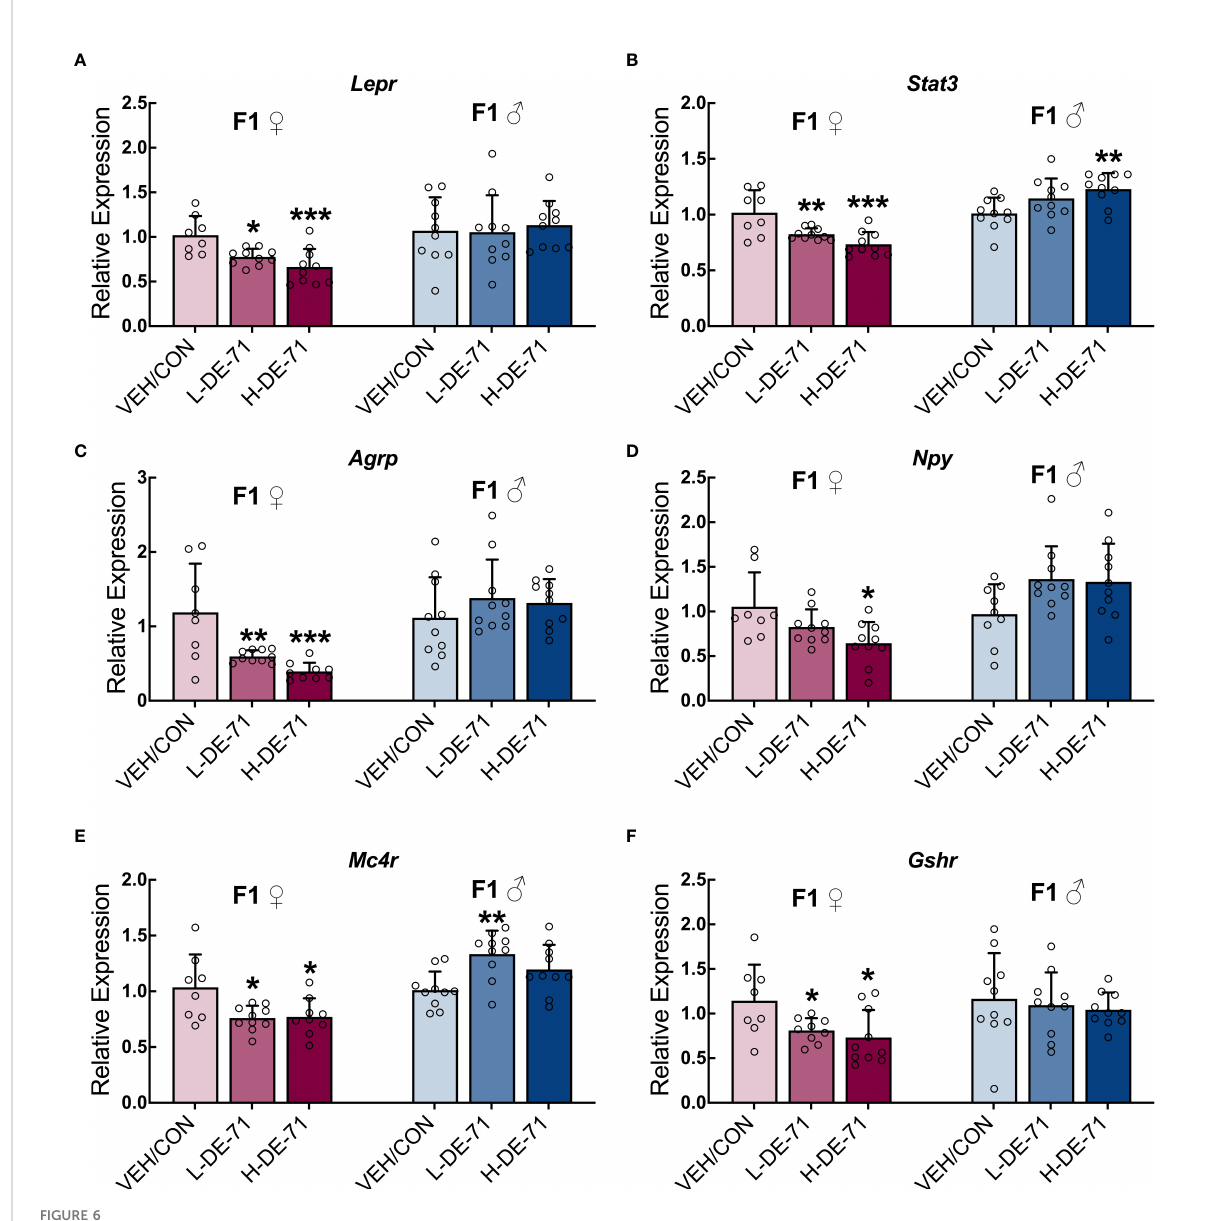
FIGURE 6 Sex-dependent alterations of hypothalamic energy balance genes in DE-71-exposed F1 offspring. Relative gene expression in hypothalamic samples of adult male and female offspring from dams orally dosed with vehicle or DE-71 was measured using RT-qPCR and mean values normalized to Actb and expressed as fold-change relative to the mean of respective VEH/CON samples. (A) Leptin receptor, Lepr (B) Signal transducer and activator of transcription 3, Stat3 (C) Agouti-related peptide, Agrp (D) Neuropeptide Y, Npy (E) Melanocortin-4 receptor, Mc4r (F) Growth hormone secretagogue receptor, Gshr . Data are represented mean±s.e.m. Sample size (n/group): Females (8-10) and males (9-10). Asterisks indicates signi fi cant difference compared to VEH/CON, * p <0.05, ** p <0.01, *** p